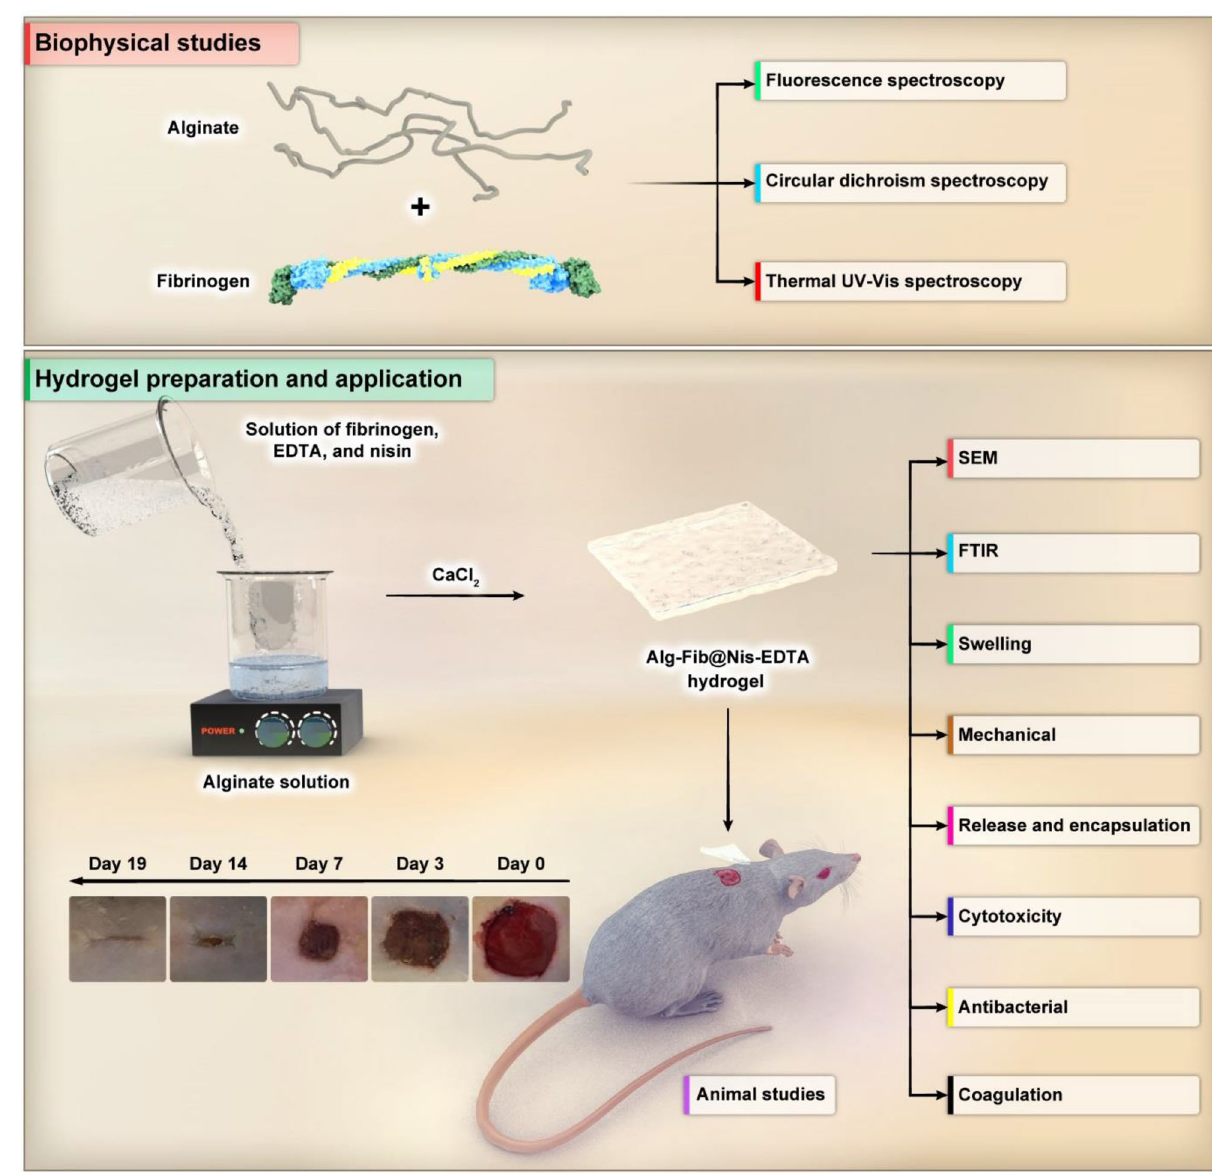
Figure 1. The schematic diagram of material preparation and application shows an overview of the present study. In the first step, biophysical and structural studies on fibrinogen protein in the presence and absence of alginate polymer were performed using fluorescence spectroscopy, Circular dichroism spectroscopy and Thermal UV–Vis spectroscopy. In the second step, the hydrogel was prepared and characterized through visual evaluation and scanning electron microscopy, Fourier-transform infrared spectroscopy, swelling ratio, mechanical study, in vitro nisin release, encapsulation efficiency , cytotoxicity assay , antibacterial activity assay, and blood coagulation assay. Finally, animal studies were performed. The optimized hydrogel was placed on rats skins wound, and the wound healing process was observed over 19 days. (Designed by Photoshop CC 2022; http:// www. adobe. com/ produ cts/ photo shop. and emission wavelengths of 300–400 nm. During these studies, fluorescence intensity of 0.06 µM fibrinogen dissolved in 20 mM sodium phosphate buffer was measured in the presence of increasing concentrations of alginate at 25, 30, and 35 °C. The mixture of protein and alginate was vortexed for 10 s and stored at room tem- perature for 2 min prior to measurements 29 . Circular dichroism spectroscopy. The secondary structure of 0.72 µM fibrinogen was evaluated in presence and absence of various concentrations of alginate by obtaining far UV (195–260 nm) circular dichroism (CD) spec- tra using an Aviv 215 Spectropolarimeter (Lakewood, New Jersey, USA) at 25 °C. In this case, fibrinogen was incubated with the mentioned concentrations of alginate for 10 min at room temperature prior to CD measure- ments. Quartz cells of 1 mm path length were employed for far UV CD spectroscopy. Buffer correction, smooth-